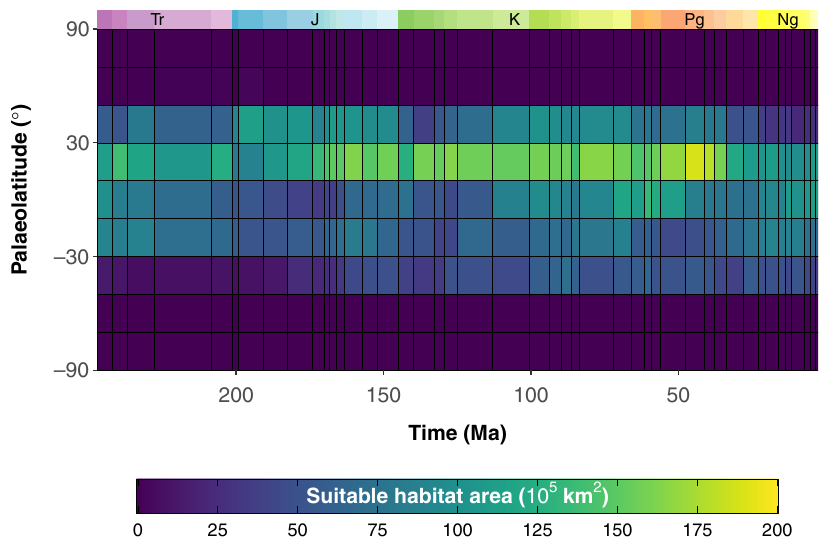
Fig. 4 Palaeolatitudinal (20° bins) estimates of climatically suitable habitat area (Anisian, Triassic to Piacenzian, Neogene) for warm-water coral reefs under binary threshold ‘ LTP ’ (least training presence). Stage-level hindcasts are based on a modern-calibrated Maxent model and area is calculated from binary predictions. Period abbreviations are as follows: Triassic (Tr), Jurassic (J), Cretaceous (K), Paleogene (Pg), and Neogene (Ng).